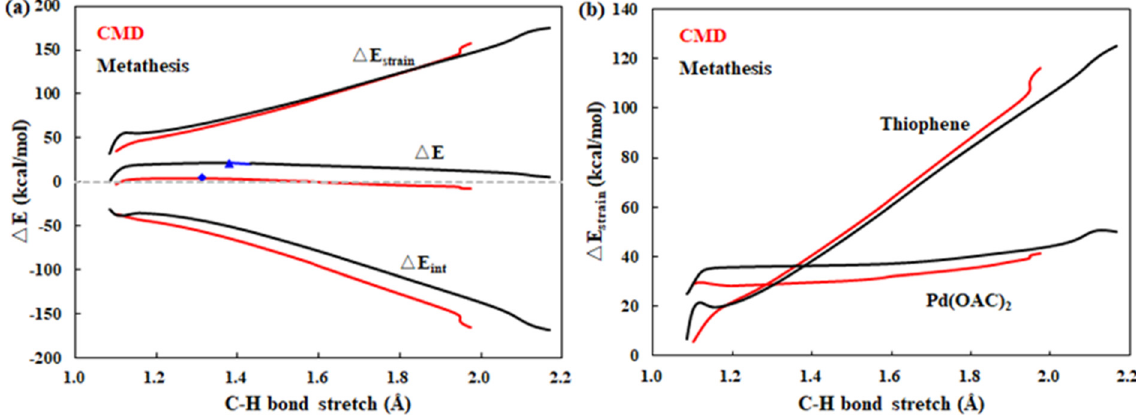
Figure 4. ( a ) Distortion/interaction model analyses for the alternative modes of deprotonation step along with the reaction coordinates; ( b ) the strain energy analyses for the deprotonation step along with the reaction coordinates for the thiophene and Pd(OAC) 2 .